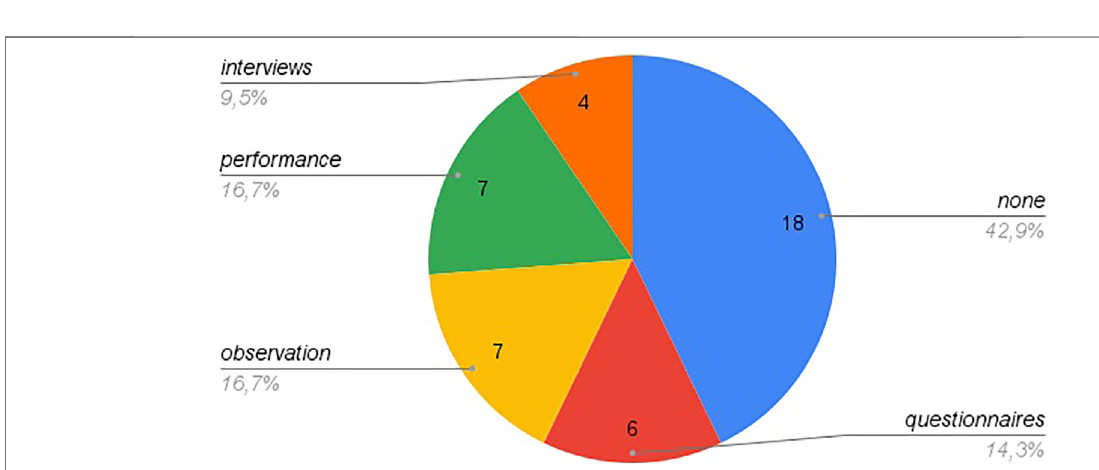
FIGURE 4 | Reported evaluation methods for AR authoring